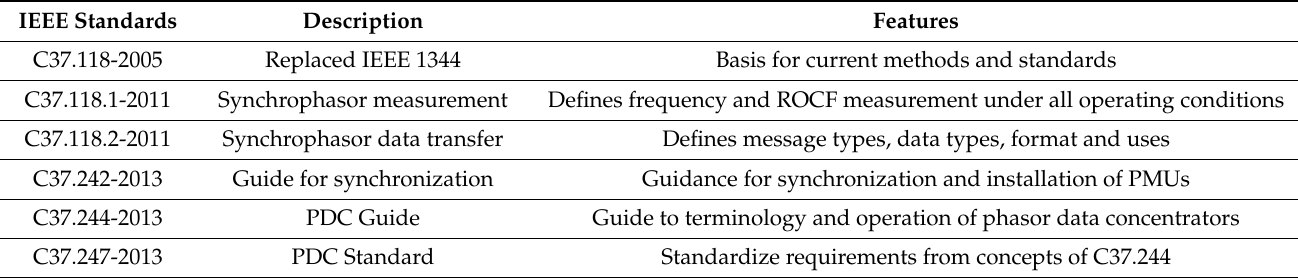
Table 5. IEEE standards of